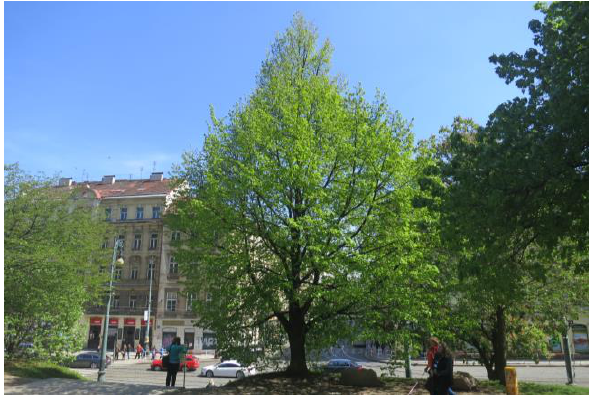
Fig. 5. A lime tree in the Mala Strana district, dedicated to the memory of an important Czech poet, Jan Neruda, was planted in 1984 (in anniversary of 150 years of the poet’s